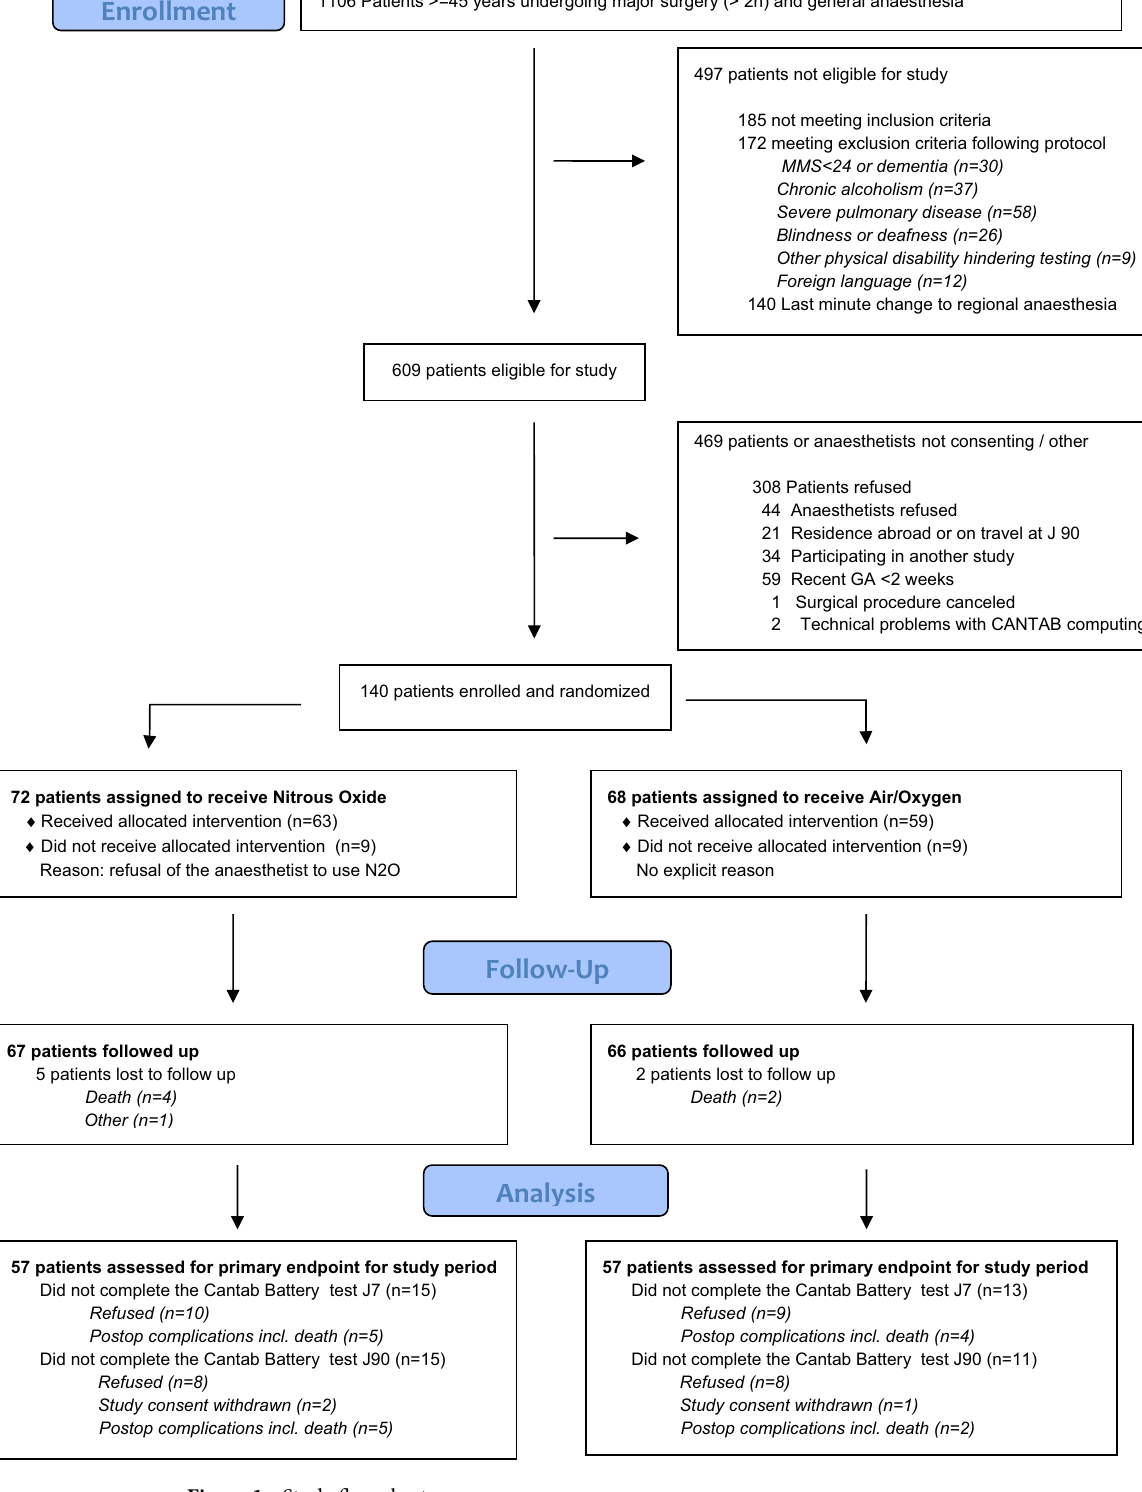
Figure 1. Study flow